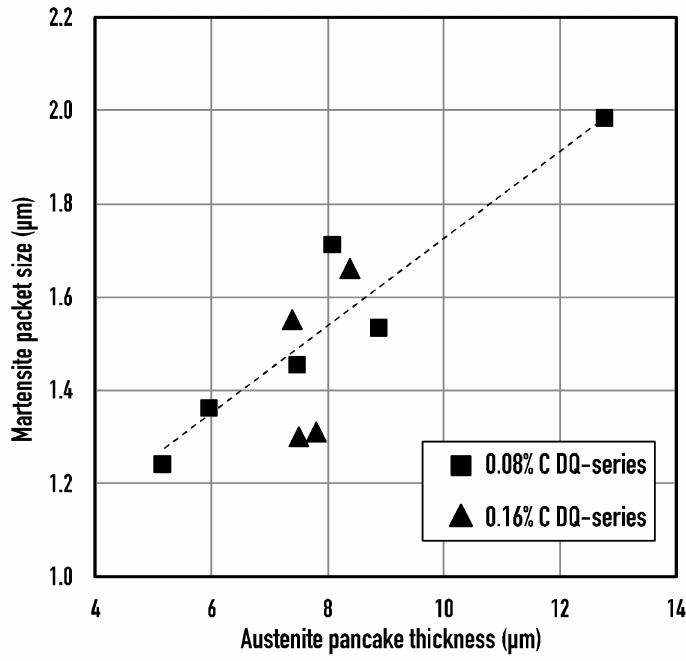
Figure 4. Correlation of martensite packet size with the parent austenite pancake thickness in direct quenched steel after non-recrystallizing hot